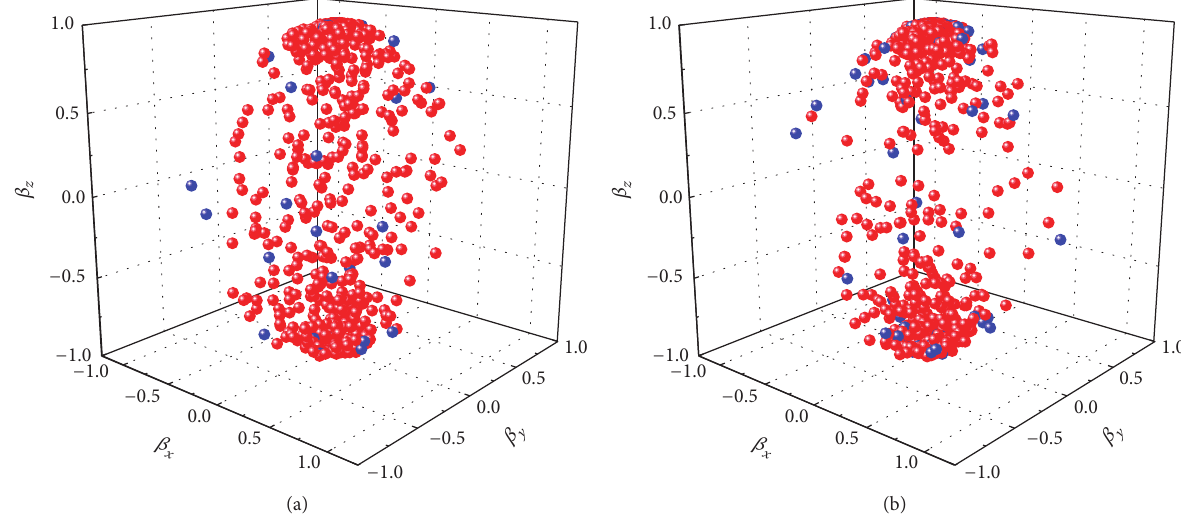
Figure 7: Same as Figure 4, but showing the results for (a) inclusive 𝐽/𝜓 mesons and (b) inclusive 𝜓(2𝑆) mesons produced in pp collisions at √𝑠 = 7 TeV.